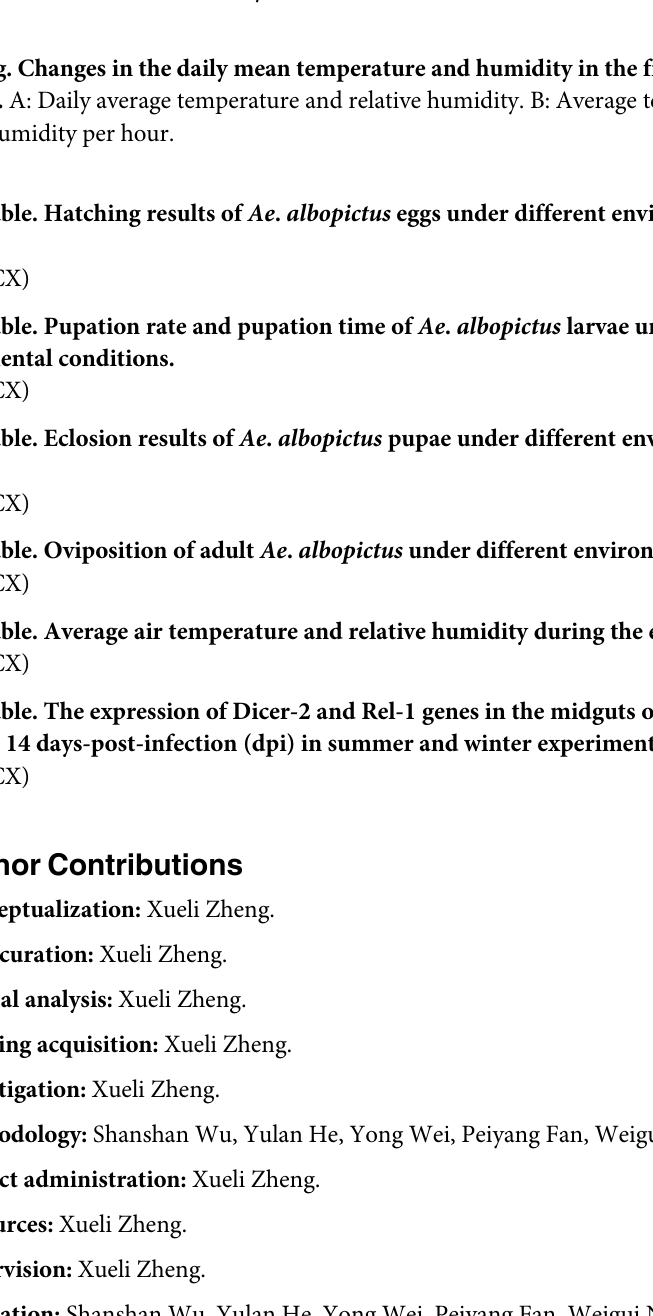
S4 Fig. The standard curve of Dicer-2, Rel-1, and β -actin expression. (TIF) S5 Fig. Changes in the relative temperature and humidity during the experiment in differ- ent environments. A: Temperature changes during the experiment in different environments. B: Variation of relative humidity in different environments. (TIF) S6 Fig. Changes in the daily mean temperature and humidity in the field during the experi- ment. A: Daily average temperature and relative humidity. B: Average temperature and rela- tive humidity per hour. S1 Table. Hatching results of Ae . albopictus eggs under different environmental condi- tions. S2 Table. Pupation rate and pupation time of Ae . albopictus larvae under different envi- ronmental conditions. S3 Table. Eclosion results of Ae . albopictus pupae under different environmental condi- tions. S4 Table. Oviposition of adult Ae . albopictus under different environmental conditions. S5 Table. Average air temperature and relative humidity during the experiment. S6 Table. The expression of Dicer-2 and Rel-1 genes in the midguts of Aedes albopictus in 7 and 14 days-post-infection (dpi) in summer and winter